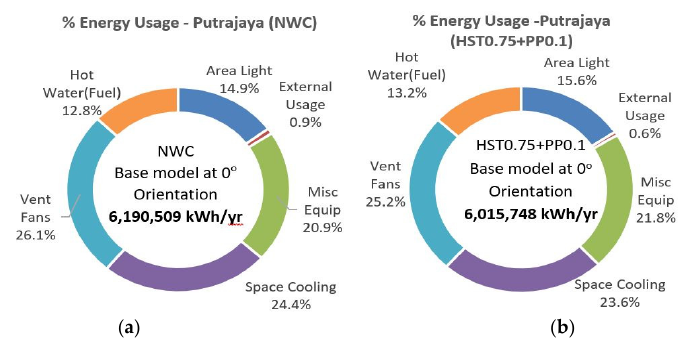
Figure 6. Percentage breakdown of annual energy consumption end-use comparison for Putrajaya: ( a ) NWC; ( b ) HST0.75 + PP0.1.